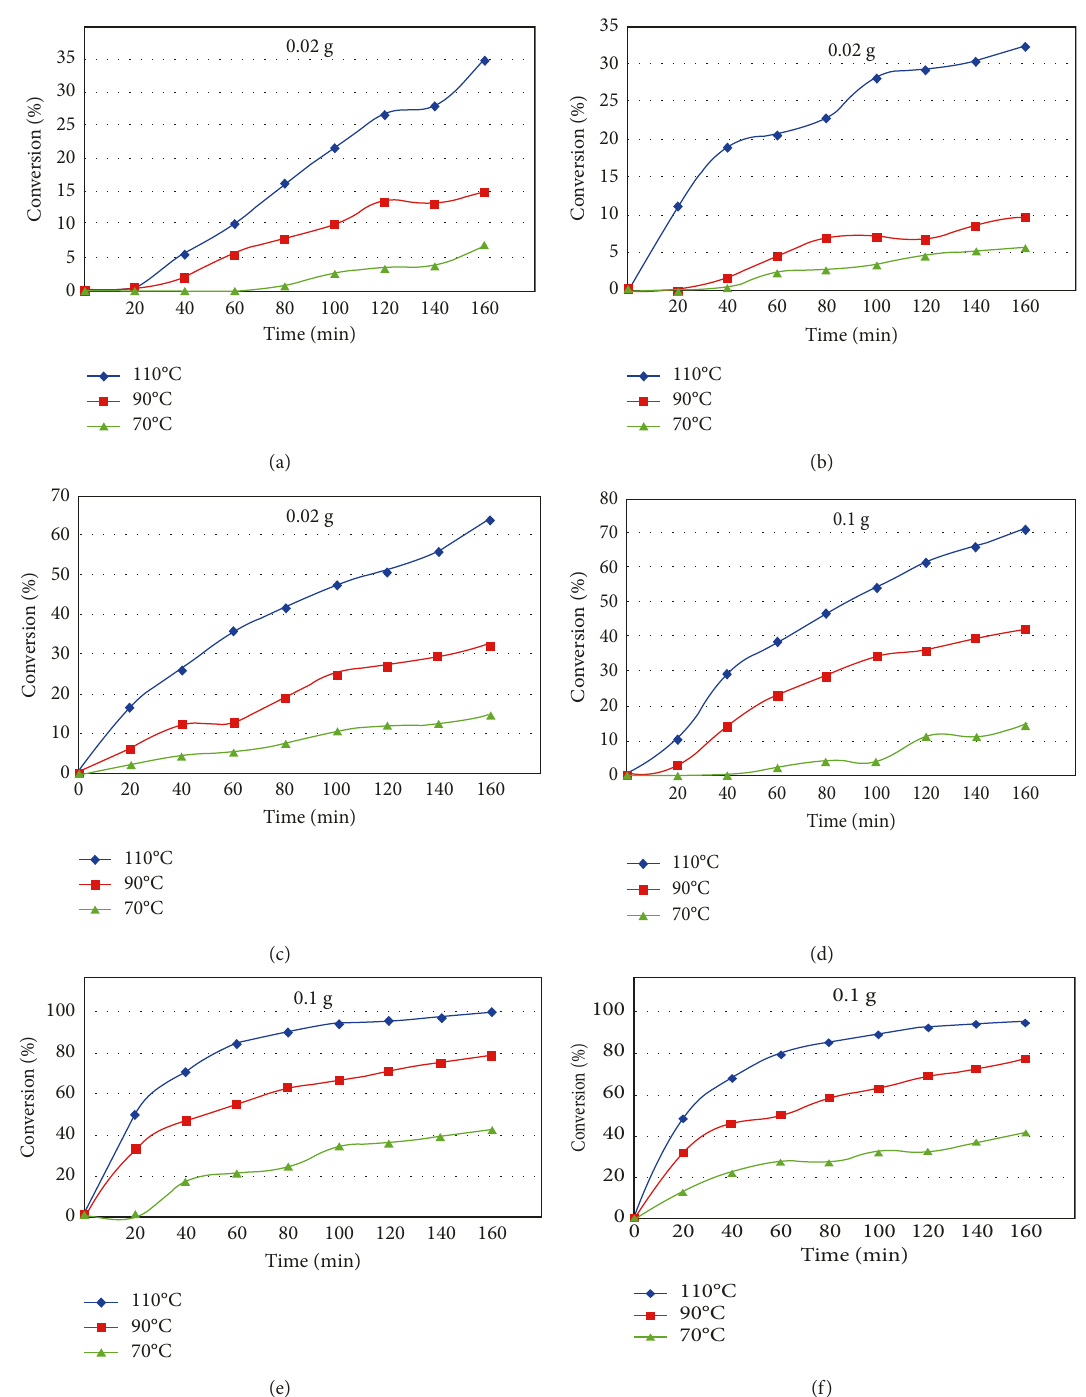
Figure 4: Effect of temperature on the catalytic activities of supported HPW catalysts for the esterification of acetic acid with heptanol. (a) HPW-K, 0.02 (g), (b) HPW-B, 0.02 (g), (c) HPW-M 0.02 (g), (d) HPW-K, 0.1 (g), (e) HPW-B, 0.1 (g), and (f) HPW-M, 0.1